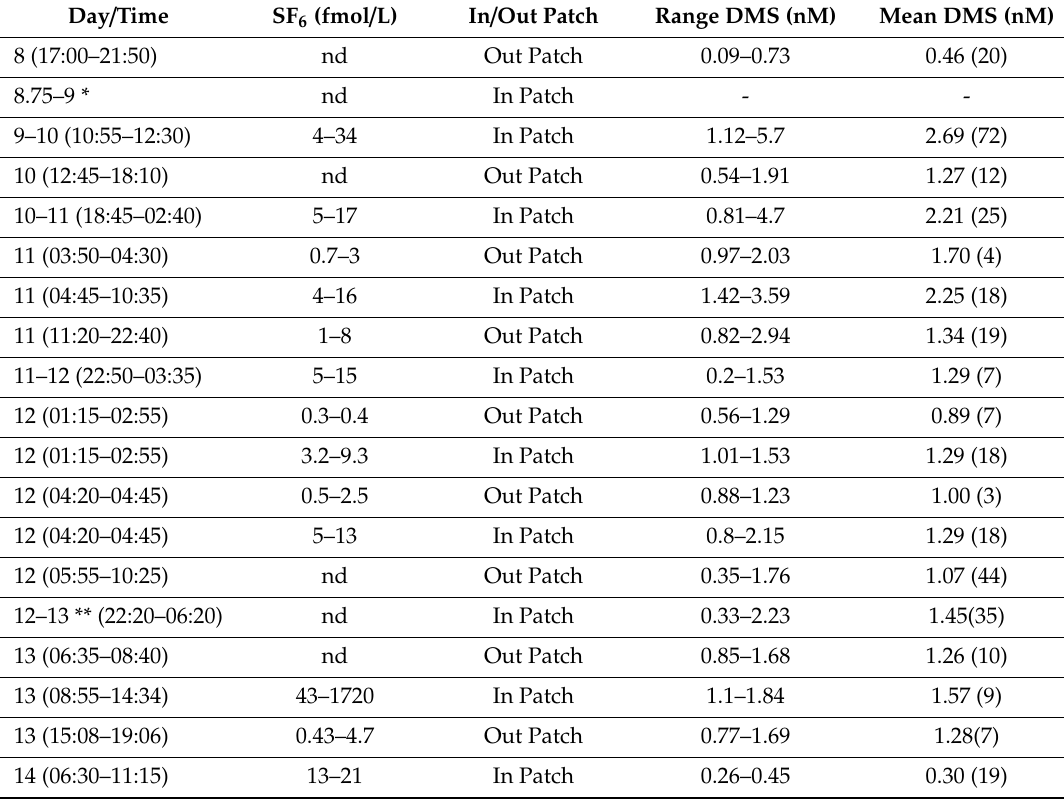
Table 2. Underway dimethylsulfide (DMS) (nM) concentrations from Lagrangian days 8 to 14 (SF 6 was used to delineate the iron fertilized “IN Patch” from the unfertilized “OUT Patch”). Day / Time SF 6 (fmol / L) In / Out Patch Range DMS (nM) Mean DMS